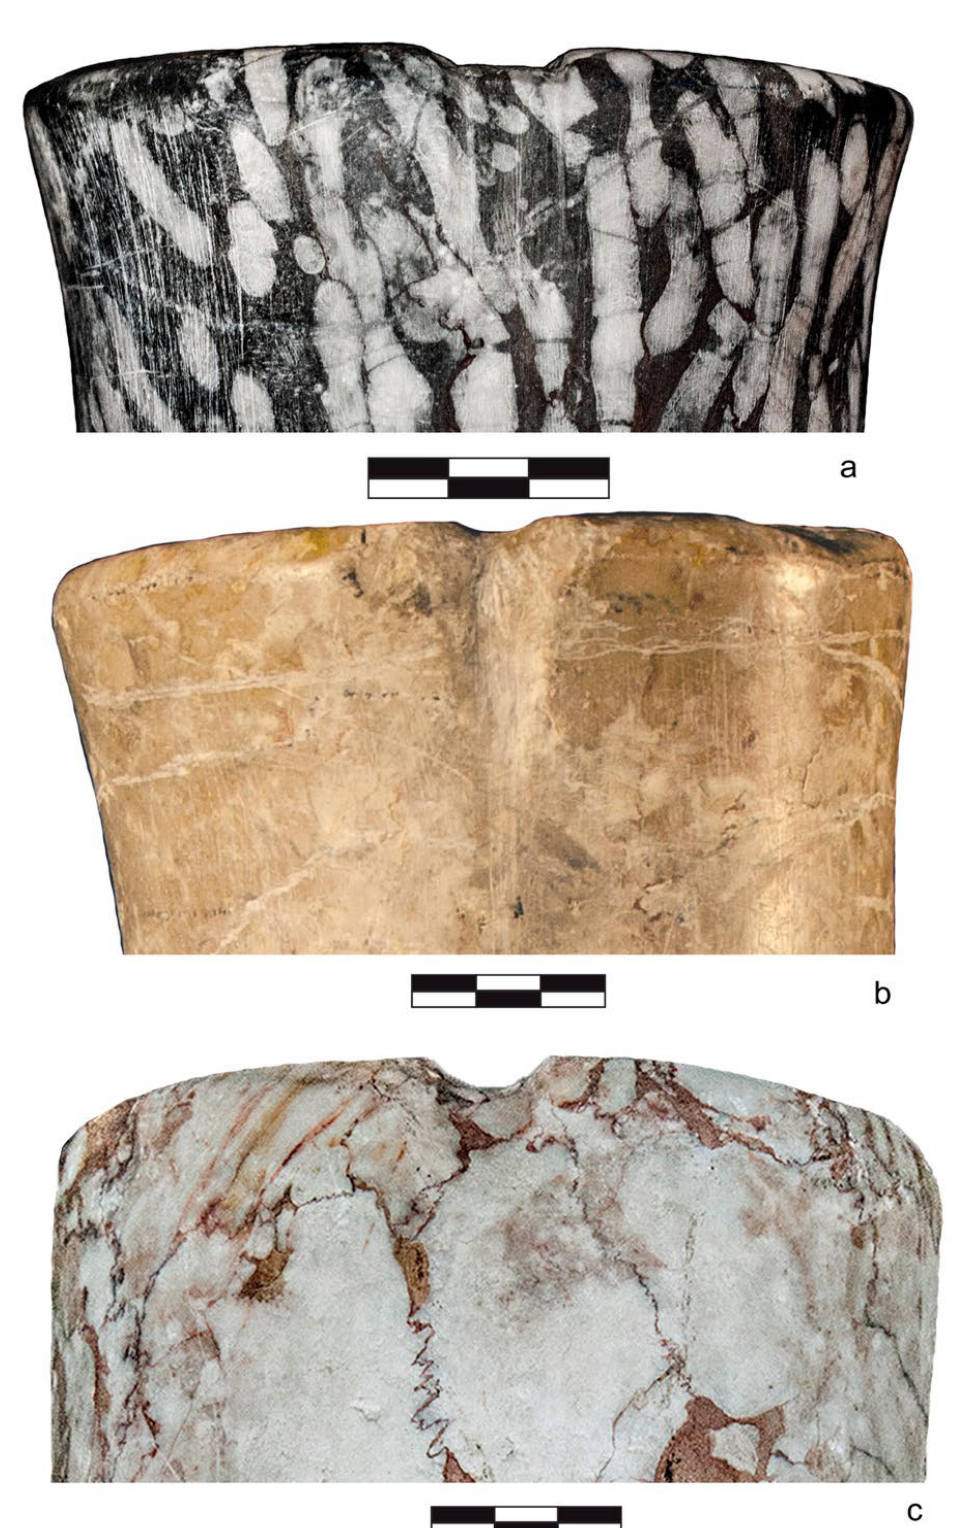
Figure 19. Types of groove profiles on the base of miniature columns from Gonur Depe: a, b. rectangular, c. arched. Scale bar is 3 cm long, separated into three 1 cm